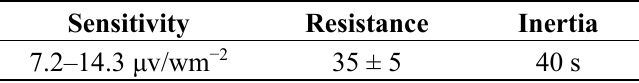
Table 2. DFY-2 Radiometer technical